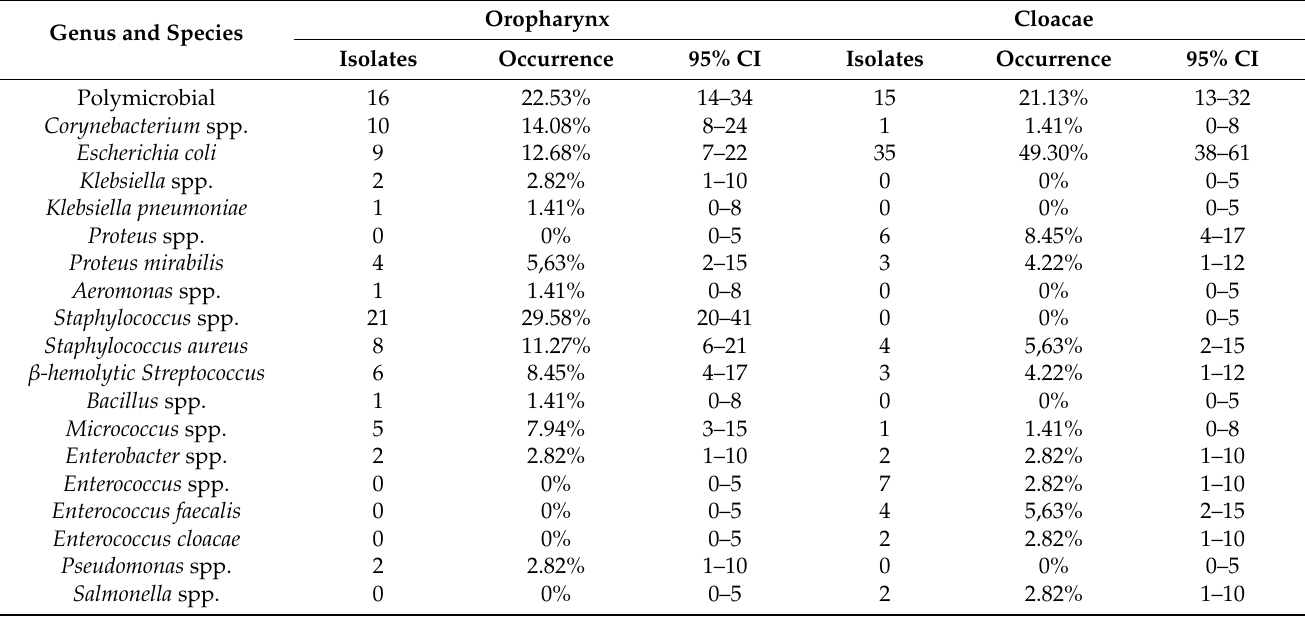
Figure 3. Scheme of the potential link between vultures and ecosystem health, considering vultures using different anthropized environments are more prone to be colonized by zoonotic pathogens than vultures using natural environments. Photographic credits: Captive individuals, Guillermo Wiemeyer; Natural environments, Bruno Osorio; Anthropized environments, Alejandro Olivares. Table 2. Isolates, occurrence and its 95% confidence interval, of aerobic bacteria isolated from oropharynx and cloacae in 71 captive Andean condors (admitted for rehabilitation and hand reared